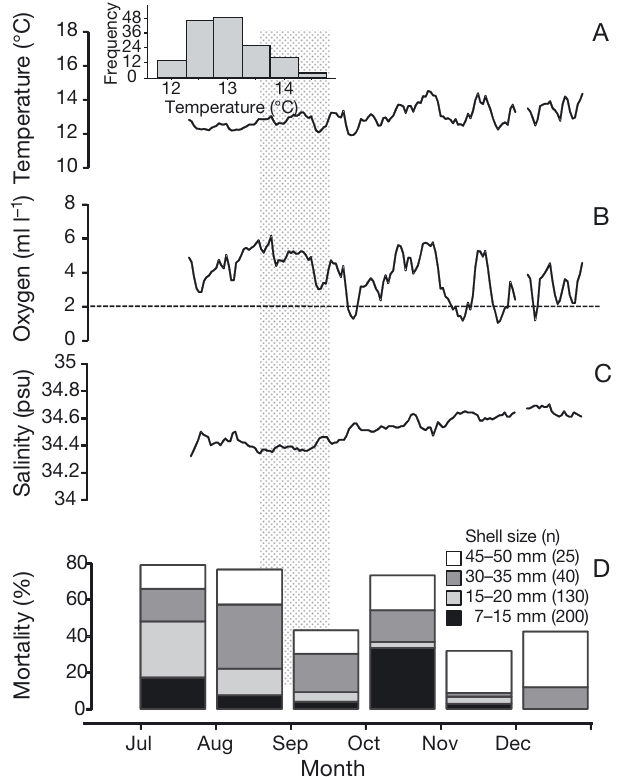
Fig. 6. Temporal fluctuations in (A) temperature, (B) oxygen concentration, and (C) salinity measured from June to December 2014 by the CEAZAMET buoy at 10 m depth in Tongoy Bay. (D) Cumulative mortalities in 4 shell range sizes of Argopecten purpuratus recorded during the scallop thinning procedure performed from July to December 2014 at the Invertec−Ostimar Co. scallop farm; each growing period lasted for ca. 4 to 5 mo. The initial number of scallops at each level of the lantern nets and in each size range (see ‘Materials and methods’) is shown in brackets. Inset in (A) shows the histogram for temperature observations recorded during the study period; the horizontal dashed line in (B) indicates hypoxia levels, and the stippled area represents the timing of the experimental